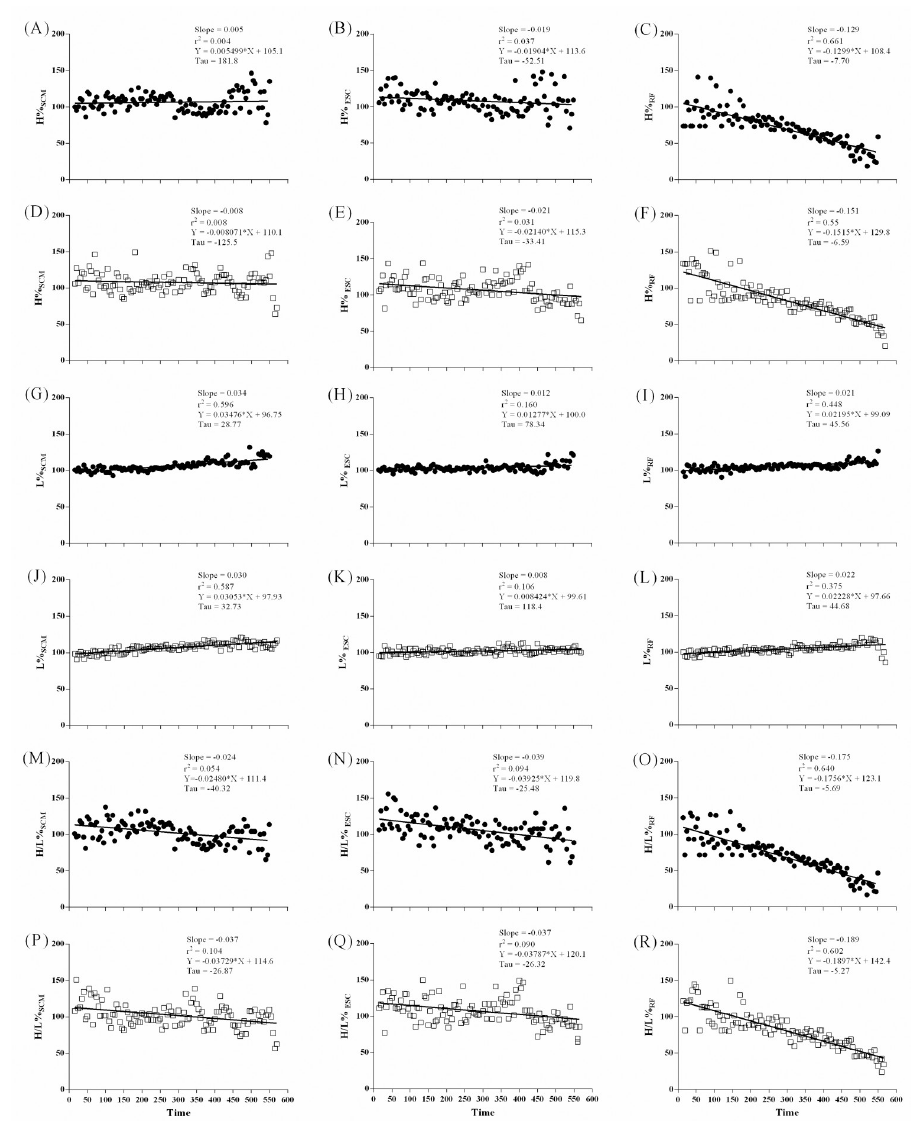
Fig 5. The high and low frequency bands, and high/low ratio of SCM (A, D, G, J, M and P), ESC (B, E, H, K, N and Q), and RF (C, F, I, O and R) muscles on ISWT, in Asthma-group (close circles) and control group (open